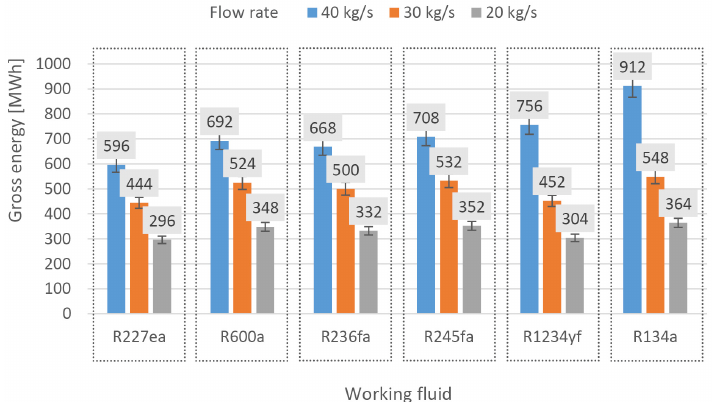
Figure 8. Comparison of the amount of electricity it is possible to generate in the AI and BI variants using the Kalina Cycle. using the Kalina Cycle.